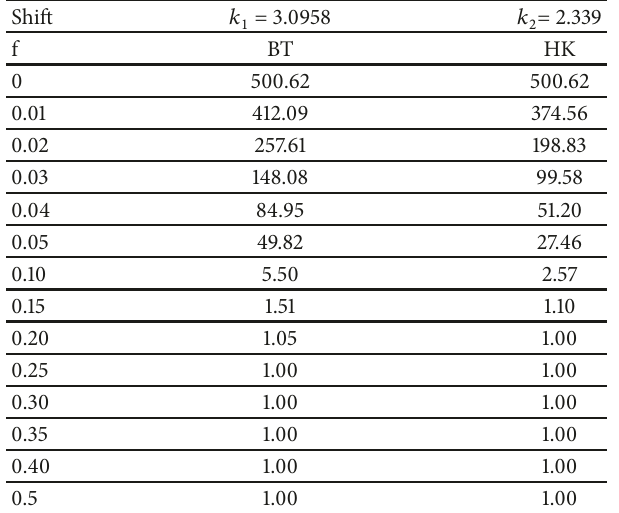
Table 16: ARLs for proposed repetitive EWMA-RSS control charts using exponential ratio-type estimators, for 𝜌 = 0.25 when 𝑟 𝑜 is 370 at 𝜆 = 0.1.